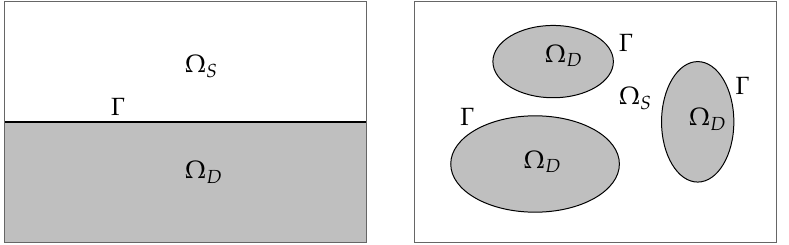
Ω D : model problem with simple ∪